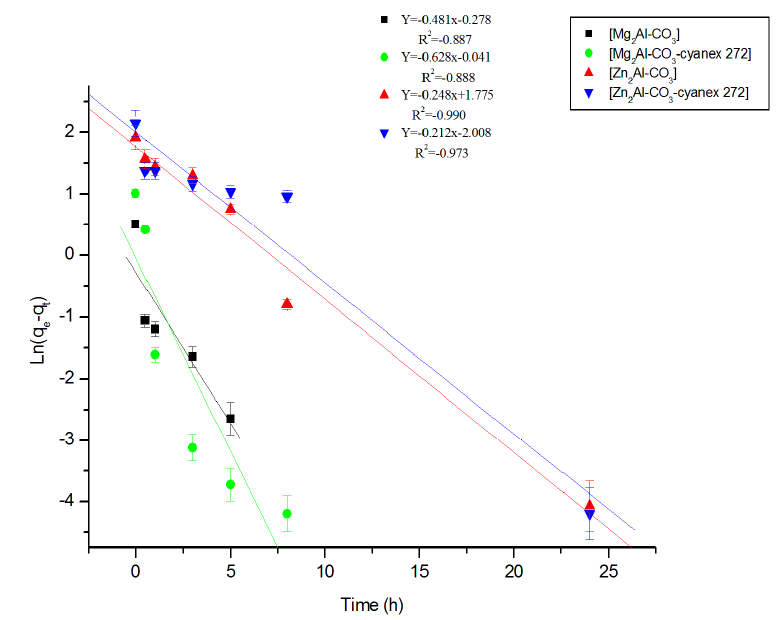
Figure 6. Kinetics of the pseudo-first order of Zn (II) extraction by the different materials.